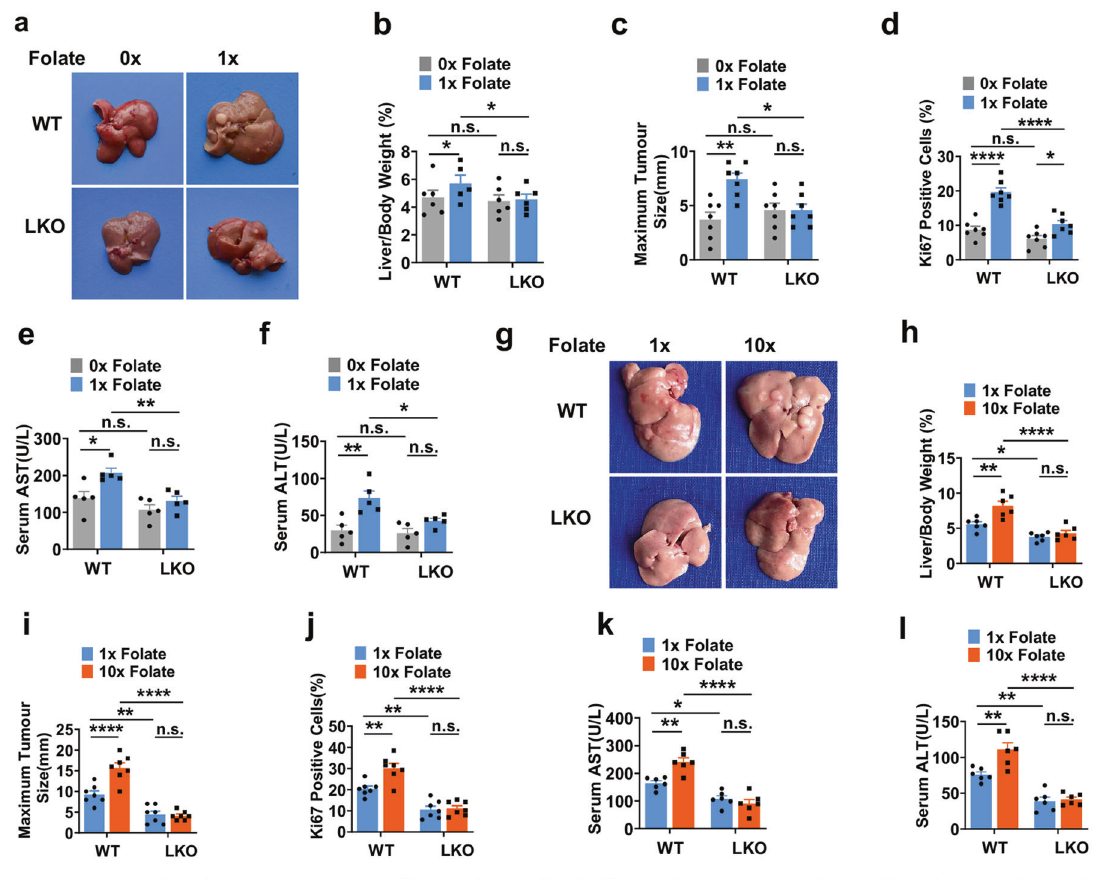
Fig. 4 MATII α is essential for folic acid-promoted cancer development. a Representative images of mouse livers from the indicated group. b , c Quanti fi cation of the ratio of liver weight to body weight ( b ) and the size of the largest tumor per mouse ( c ) fed with folate free diet. Mean ± s.e.m. of n = 5 – 7 biologically independent experiments, one-way ANOVA test. d Quanti fi cation of Ki67 staining of mice liver tissues. Seven fi elds each, mean ± s.e.m., one-way ANOVA test. e , f Serum contents of AST ( e ) and ALT ( f ) contents in mice that fed with indicated folate diet. Mean ± s.e.m. of n = 5 biologically independent experiments, one-way ANOVA test. g Representative images of mouse livers from the indicated group. h , i Quanti fi cation of the ratio of liver weight to body weight ( h ) and the size of the largest tumor per mouse ( i ) fed with folate free diet. Mean ± s.e.m. of n = 5 – 7 biologically independent experiments, one-way ANOVA test. j Quanti fi cation of Ki67 staining of mice liver tissues. Seven fi elds each, mean ± s.e.m., one-way ANOVA test. k , l Serum contents of AST ( k ) and ALT ( l ) contents in mice that fed with indicated folate diet. Mean ± s.e.m. of n = 6 biologically independent experiments, one-way ANOVA test. n.s. donates for no signi fi cance, * P < 0.05, ** P < 0.01, and **** P < (Fig. 5e, f and Supplementary Fig. S6b). In addition, double knockdown of MATII α and VCIP135 dramatically inhibits the growth in Huh7 and MHCC-97H cells (Fig. 5g and Supplementary Fig. S6c). Meanwhile, we found that MTX and FIDAS-5 (MAT2A inhibitor) synergistically repressed cell proliferation (Fig. 5h).